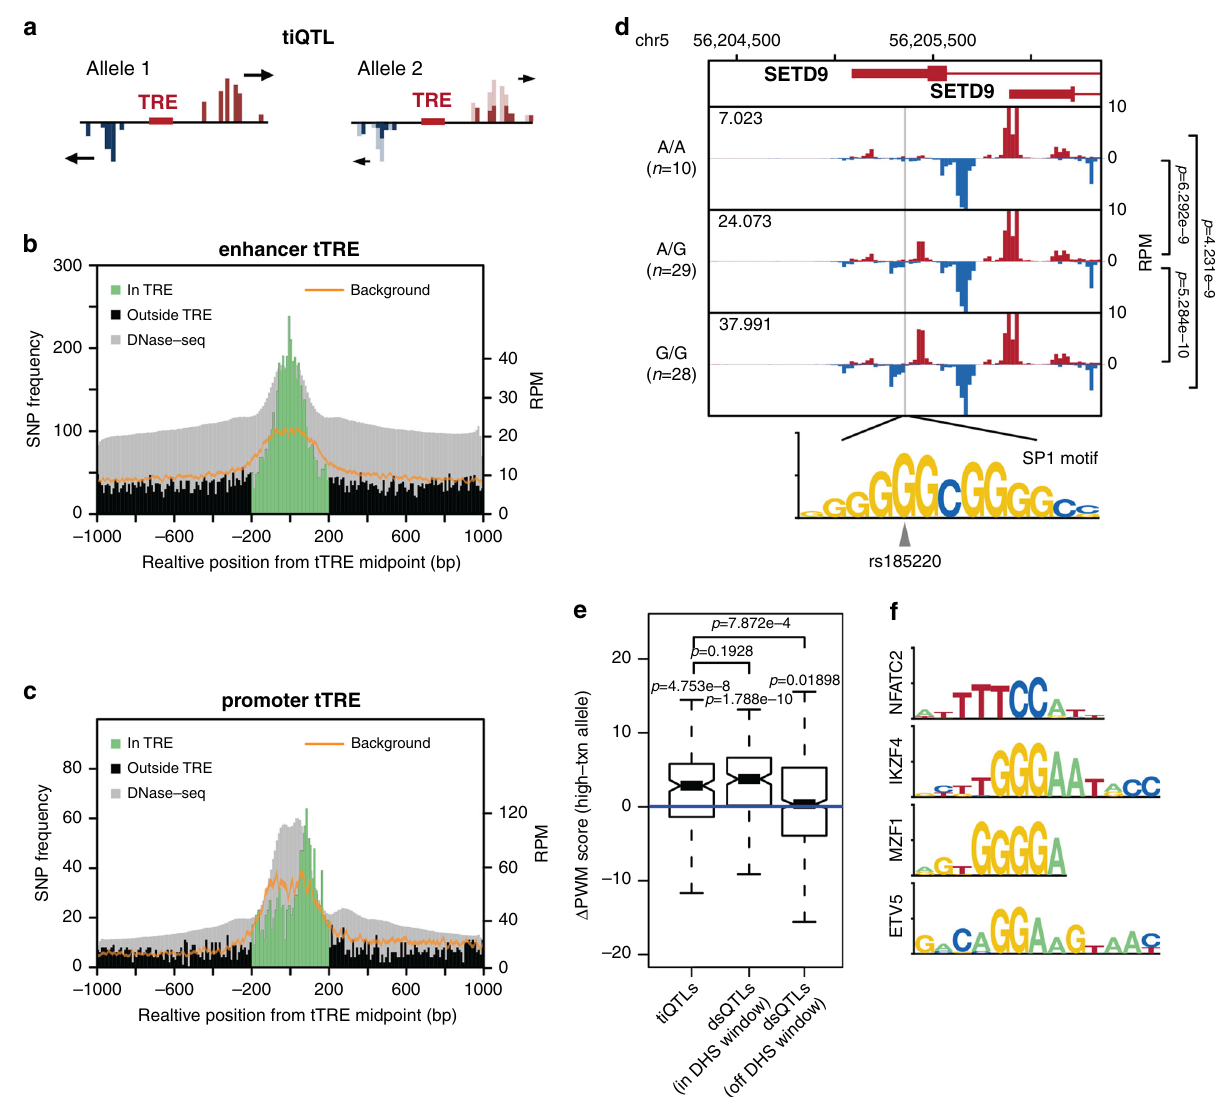
Fig. 3 Transcription initiation QTLs are enriched in tTREs and affect TFBS motifs. a Transcription initiation QTL (tiQTL) schematic. b tiQTLs are enriched at enhancer midpoints. A histogram of QTL frequency around enhancer midpoints with the expected background distribution with 99% con fi dence interval (sampled from all SNPs in the same region) shown in orange and aggregate DNase-seq track shown in gray. c tiQTLs are enriched at promoter TSSs. As in b , at promoters except oriented so that the strand with the dominantly transcribed TSS (usually gene) is downstream of tTRE center. d Average PRO-cap signal separated by genotype at tiQTL rs185220. The alternate allele creates a perfect match to the SP1 binding motif. Mean normalized transcription initiation levels for each genotype indicated in the upper left corner. Comparison of transcription initiation index between groups using two-sided Wilcoxon test. Exact p -values are p = 6.3 × 10 9 between A/A and A/G, p = 5.3 × 10 − 10 between A/G and G/G, and p = 4.2 × 10 − 9 between A/A and G/G. e Difference in PWM scores between tiQTL high transcription and low transcription alleles with effect size not equal to zero. Center line of boxplot indicates the median, box limits are the 25th and 75th quantiles, whiskers are the 1.5x interquartile range, and the notch re fl ects the 95% con fi dence interval of the median. DNase hypersensitivity QTLs are shown for comparison. P -values above each group are single sample two-sided Wilcoxon tests. Exact p -values are p = 4.8 × 10 − 8 , p = 1.8 × 10 − 10 , and p = 0.019. P -values between groups are two-sided Wilcoxon tests. Exact p values are p = 7.9 × 10 − 4 between tiQTLs and off window dsQTLs and p = 0.19 between tiQTLs and in window dsQTLs. ( n = 215, 815, and 603 QTLs respectively). f Motifs most often affected by in-tTRE tiQTLs (>20% increase over